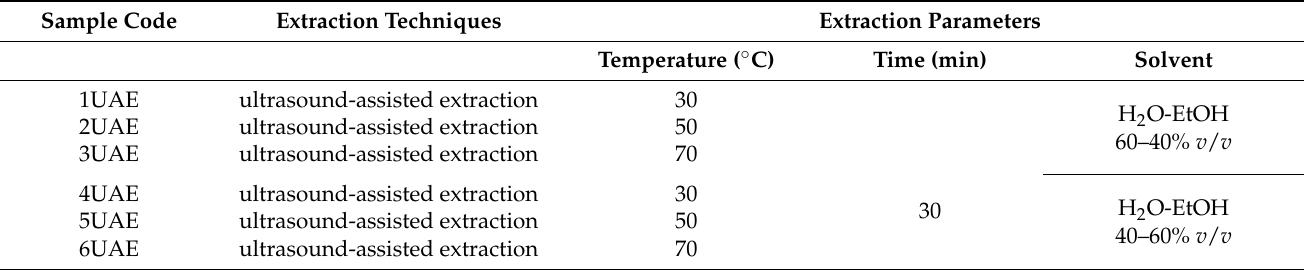
Table 1. Feijoa flower samples and parameters of the green extraction techniques